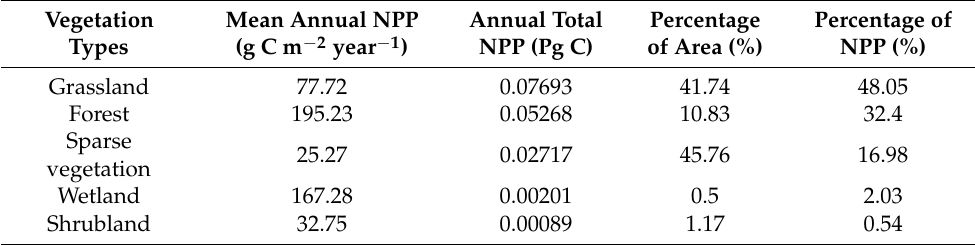
Table 2. Mean annual and total NPP over different vegetation types from 2003 to 2018.